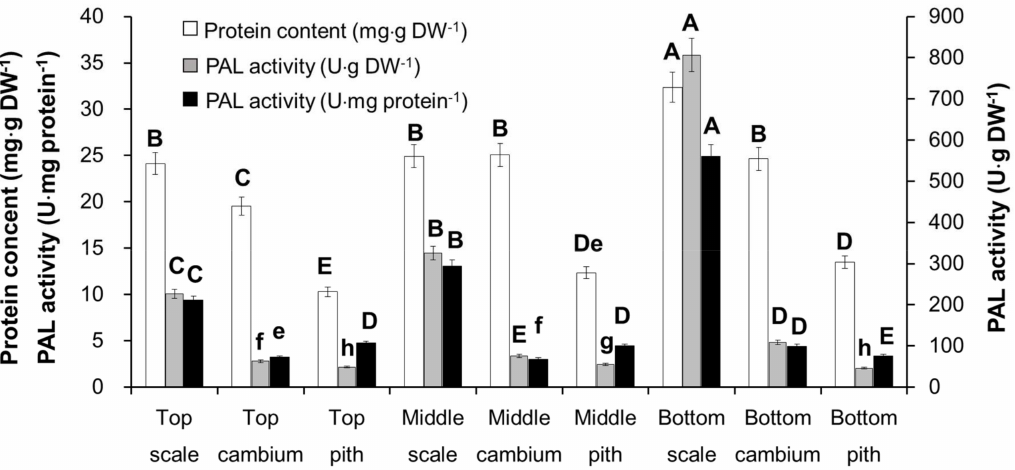
Figure 3. PAL activity and total protein content determination in different tissues and different parts of C. deserticola . Letters above the columns represent significance (A–I: p < 0.01; a–h: p <